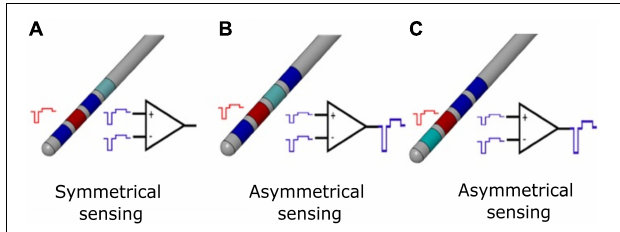
FIGURE 1 | Differential sensing configurations for conventional DBS electrode. (A) Symmetrical sensing employs two recording contacts (blue) adjacent to the stimulation contact (red); at the inputs of the differential amplifier, the common mode stimulation artifact (in the ideal case of balanced impedances) is the same, and for an ideal common mode rejection ratio (CMMR), the output of the stimulation artifact is canceled by subtraction. (B) Asymmetrical sensing employs two recording contacts (blue) in the opposite position but at different distance compared to the stimulation contact (red), or two recording contacts (blue) in the same position and at different distance compared to the stimulation contact (red). At the inputs of the differential amplifier, the common mode stimulation artifacts (in the ideal case of balanced impedances) are not the same; even for an ideal CMMR, the output of the stimulation artifact is not canceled by subtraction. In real case scenario, impedances are unbalanced and the CMMR is not ideal; therefore, asymmetrical sensing implies a further worsening of the recording configuration. (C) Asymmetrical sensing with two adjacent contacts. The panel is organized as in (B) and the same comments